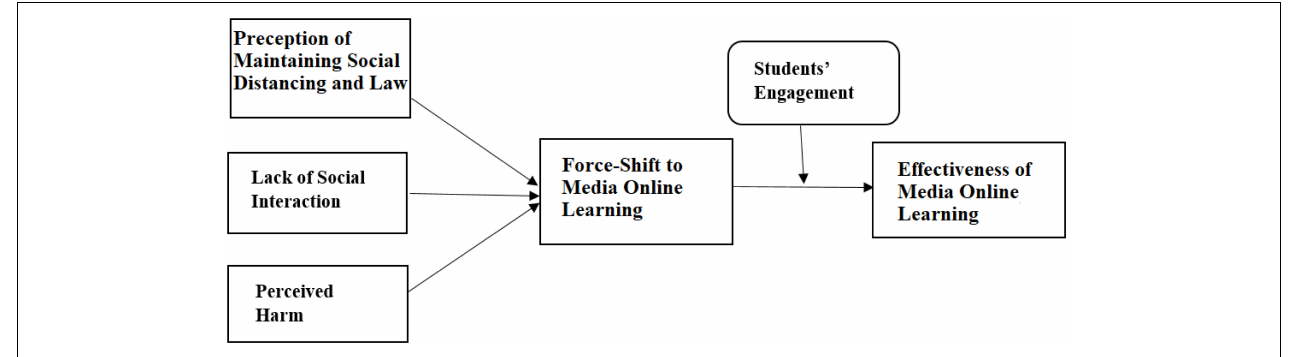
FIGURE 1 | Conceptual